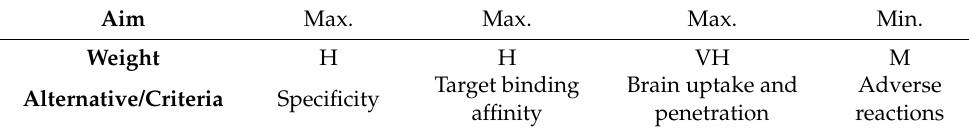
Table 4. Selected importance weights of the criteria for the sensitivity analysis. Aim Max. Max. Max. Min.